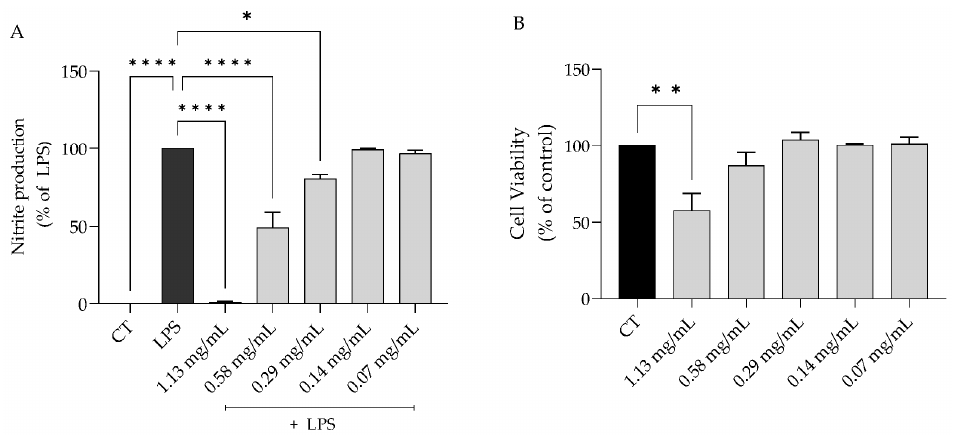
Figure 5. Santolina rosmarinifolia essential oil prevented RAW264.7 macrophage’s activation